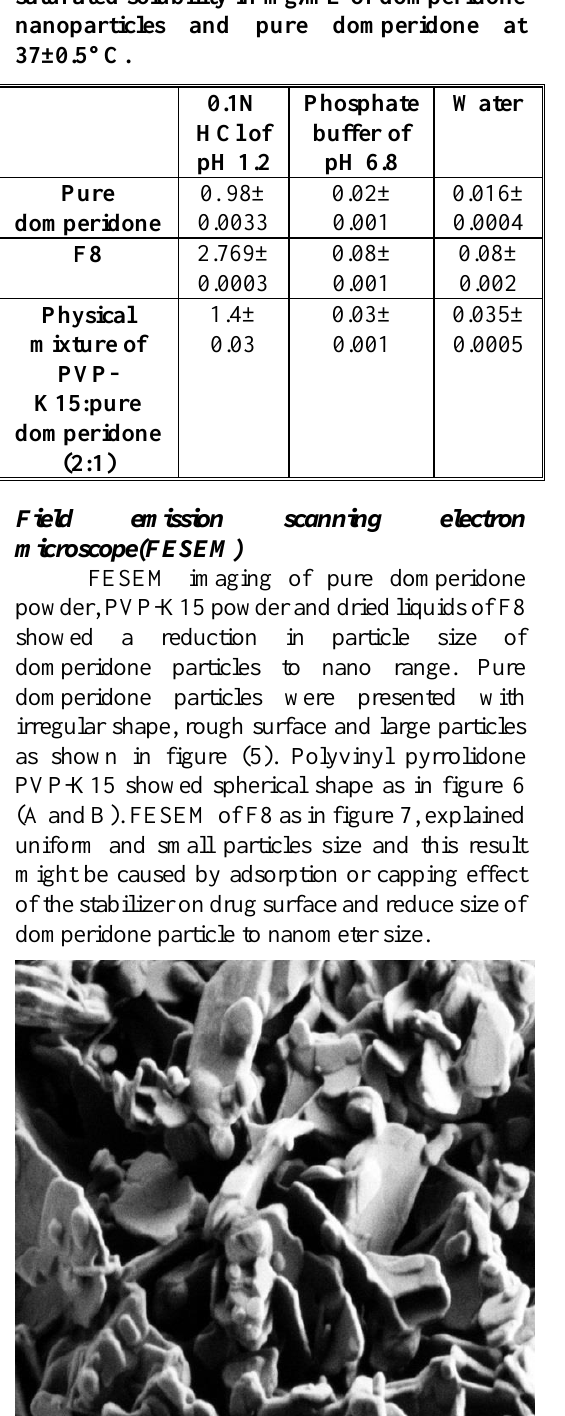
Table 3. The average (±SEM, n=3) of saturated solubility in mg/mL of domperidone nanoparticles and pure domperidone at